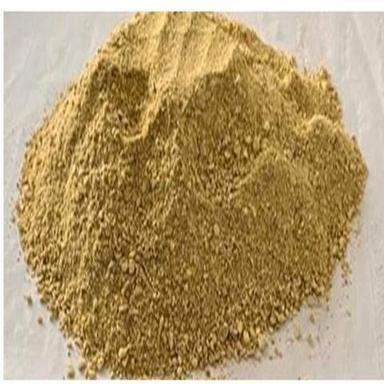
Citrus limetta fruit peel powder.